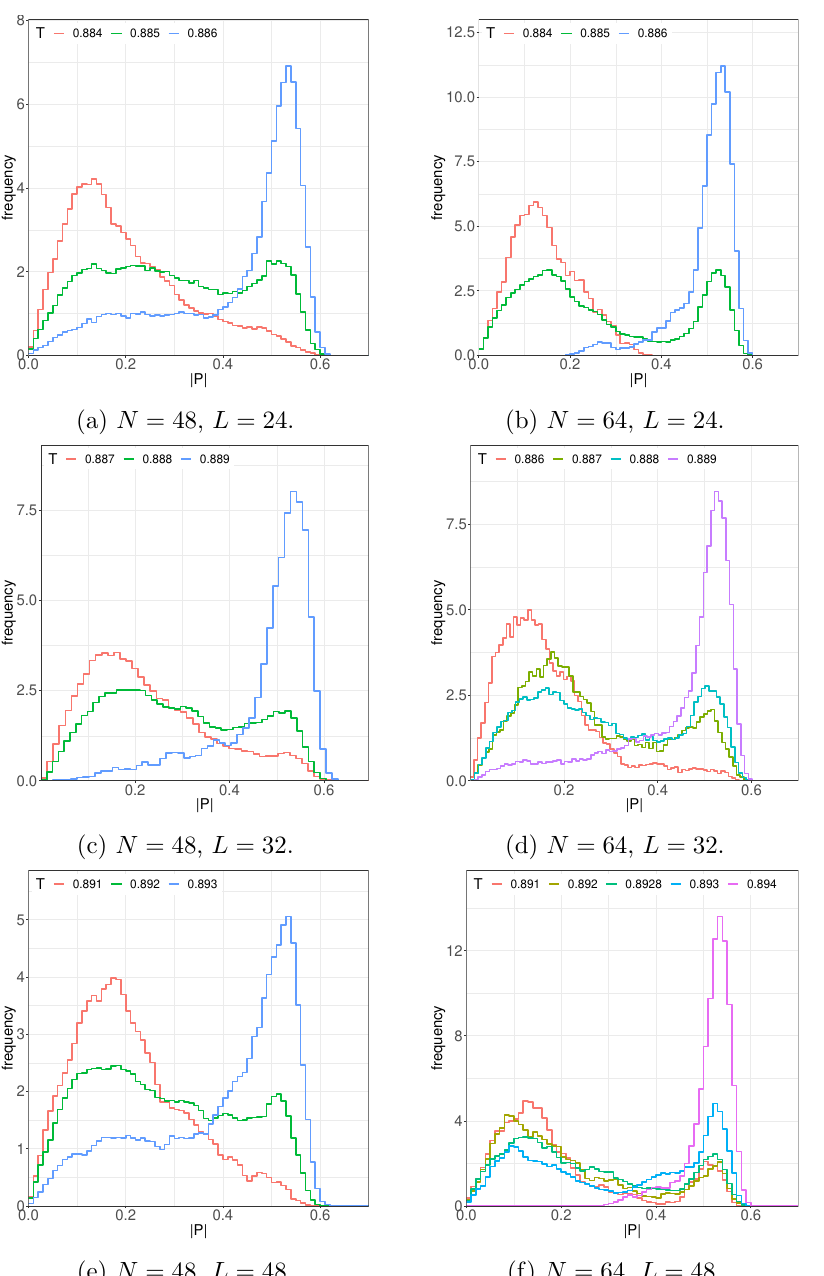
Figure 5. Histogram of the order parameter j P j close to the transition temperature for the D = 10 theory.